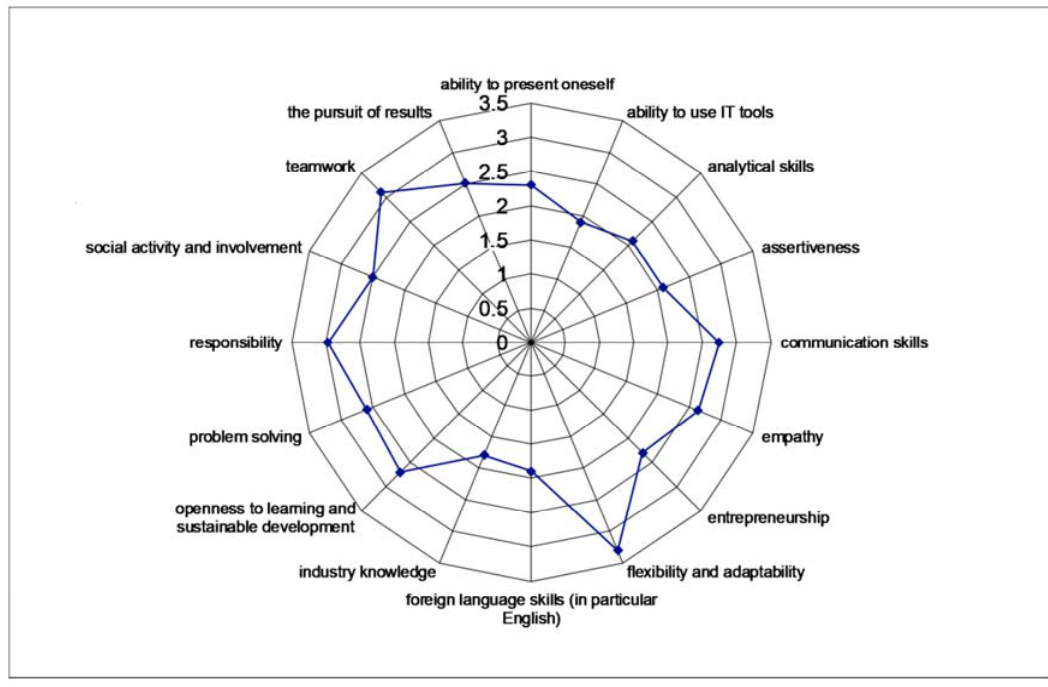
Figure 6. The impact of extracurricular activities on competency development of the respondents.